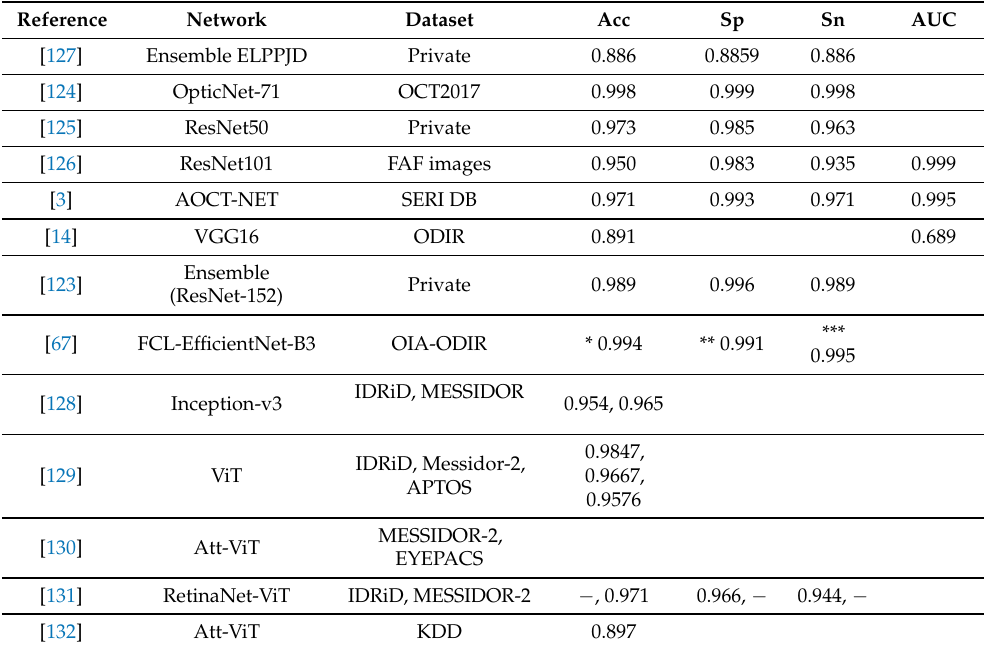
Table 6. Summary of Deep Learning Methods for the Detection of Multiple Retinal